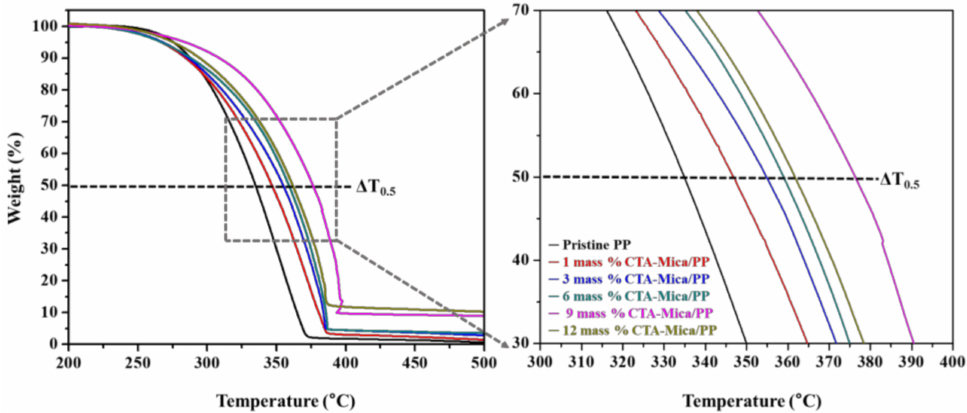
Figure 6. TGA curves for CTA-Mica/PP